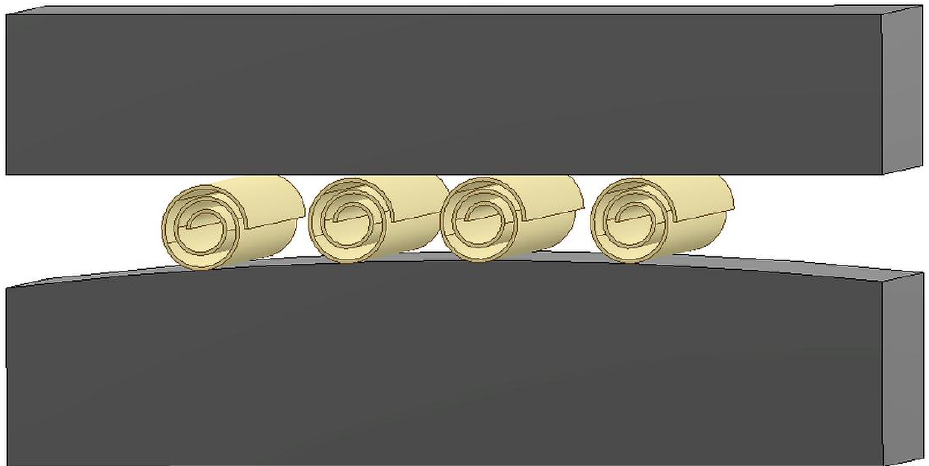
Figure 12. Schematic of anti-wear mechanism for HNTs nanofluids. A reduction of the real area of contact and sliding between surfaces with no deposition is proposed.